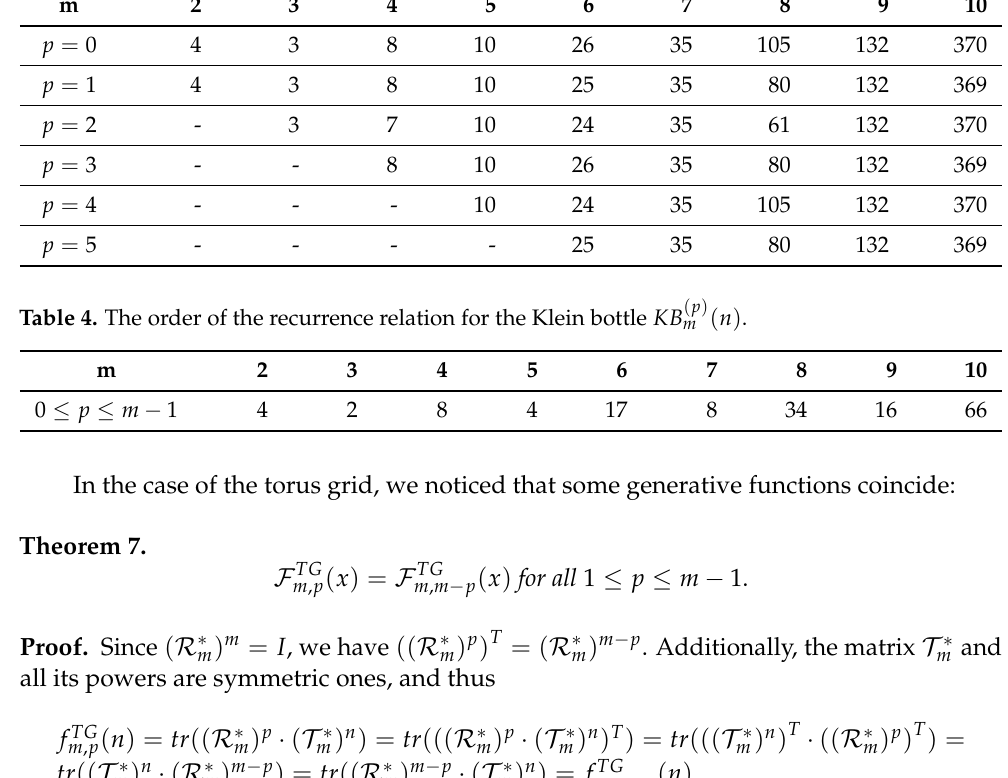
Table 3. The order of the recurrence relation for the torus graphs TG